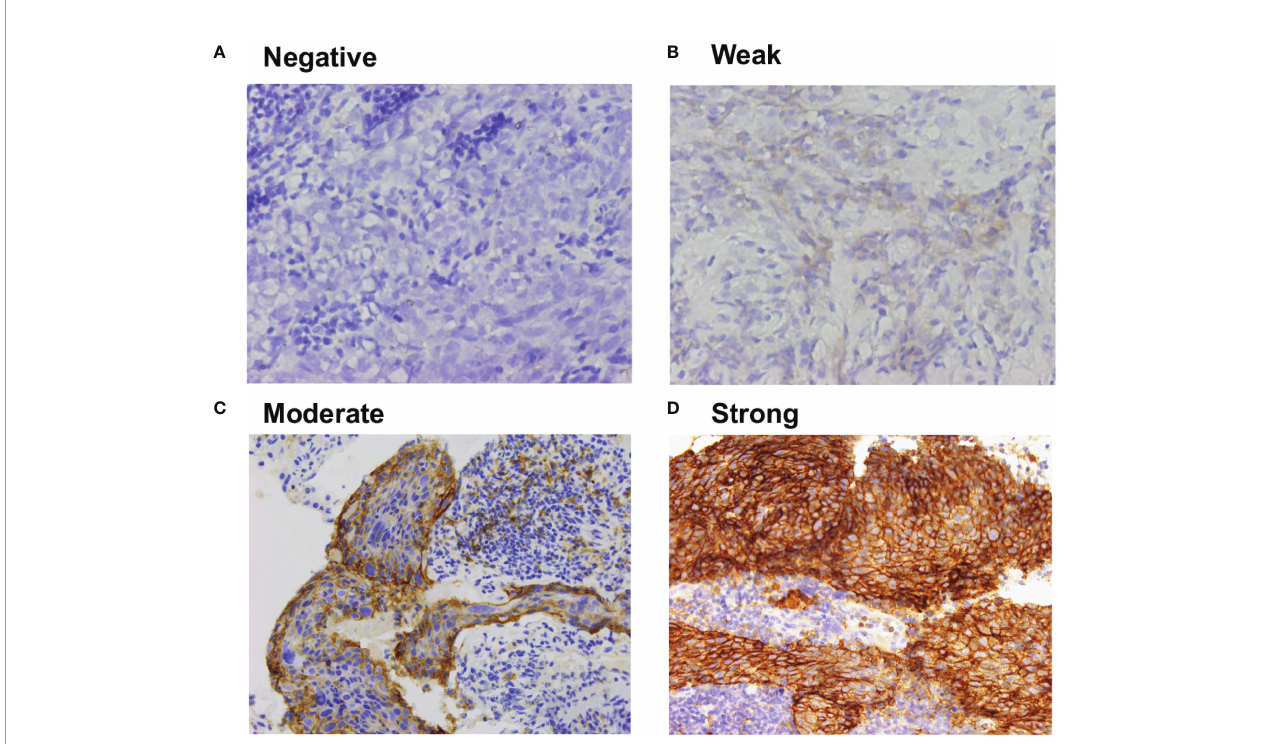
FIGURE 1 | Representative immunohistochemistry of (A) negative, (B) weak, (C) moderate, and (D) strong PD-L1 staining in NPC tumor tissues. All the images are 40X magni fi cation, The de fi nition of negative was no staining, weak staining was yellow particles, moderate staining was yellow – brown, and strong staining was brown.